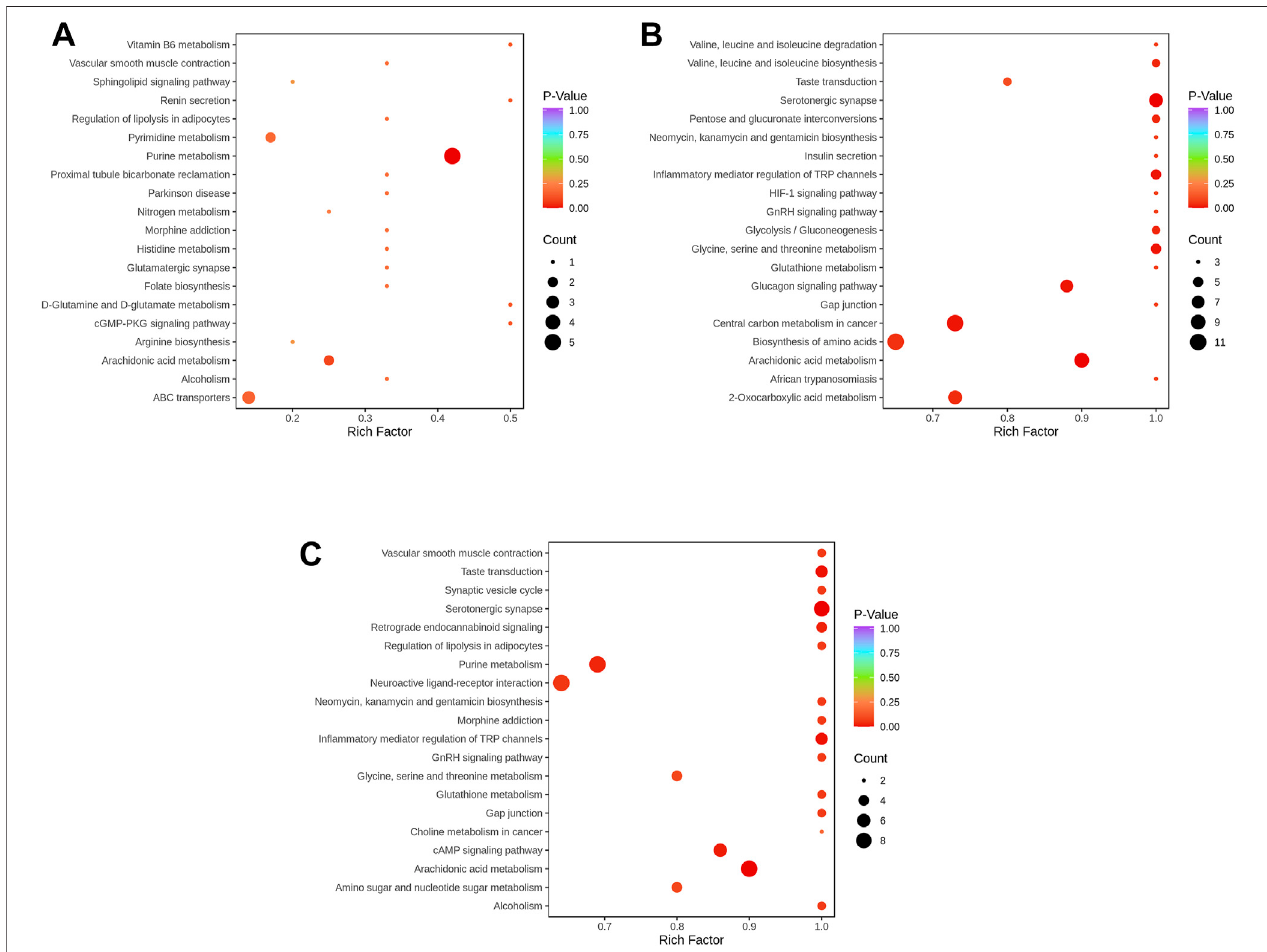
FIGURE 4 | KEGG Enrichment analysis of differential metabolites. ( (A) ZA vs. ZB; (B) ZA vs. ZC; (C) ZB vs. ZC; the color of the dot is p -value. The redder it is, the more signi fi cant the enrichment is. The size of the dot represents the number of differential metabolites in pathway enriched).